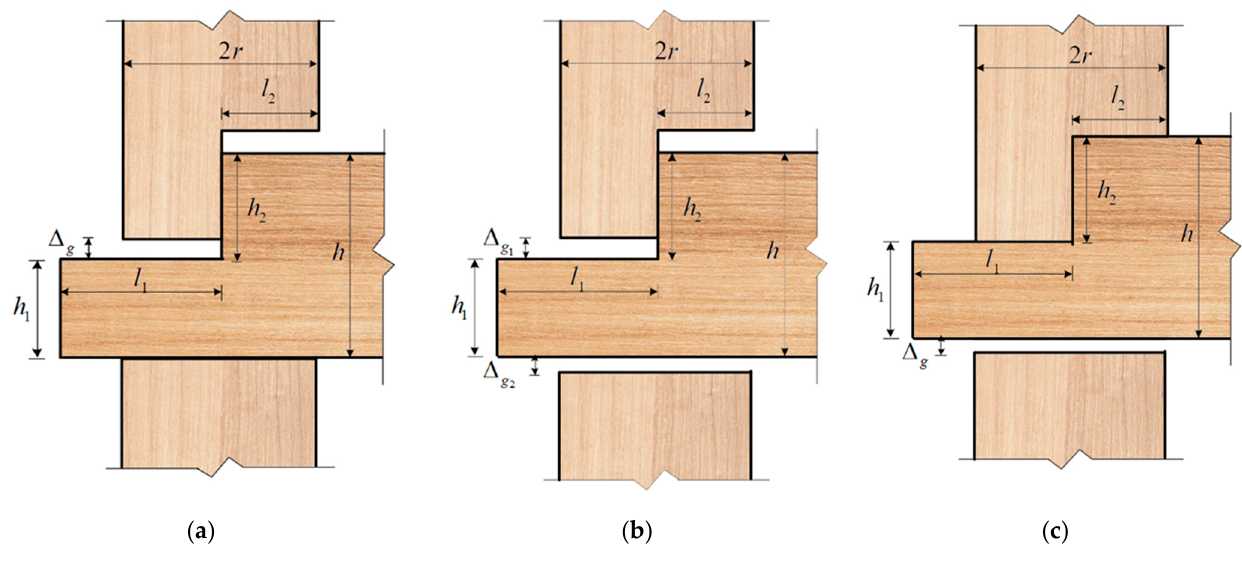
Figure 7. The possible forms of gaps.